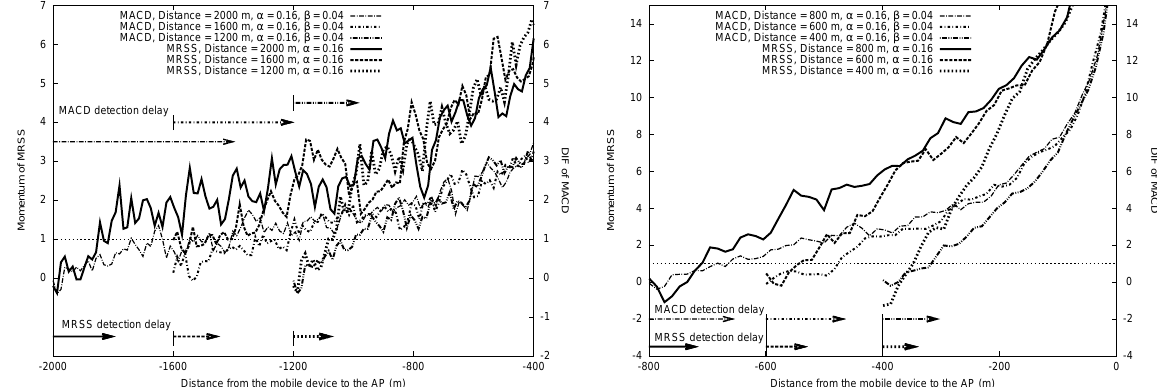
Figure 9. The effect of approaching movement in the Mobile WiMAX